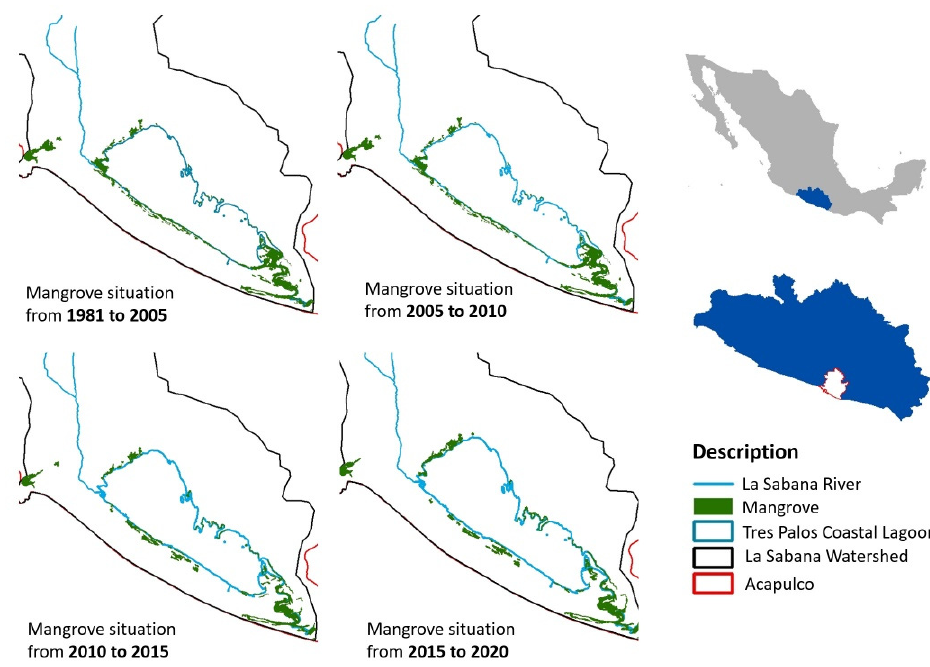
Figure 8. Mangrove loss from 1981 to 2020.